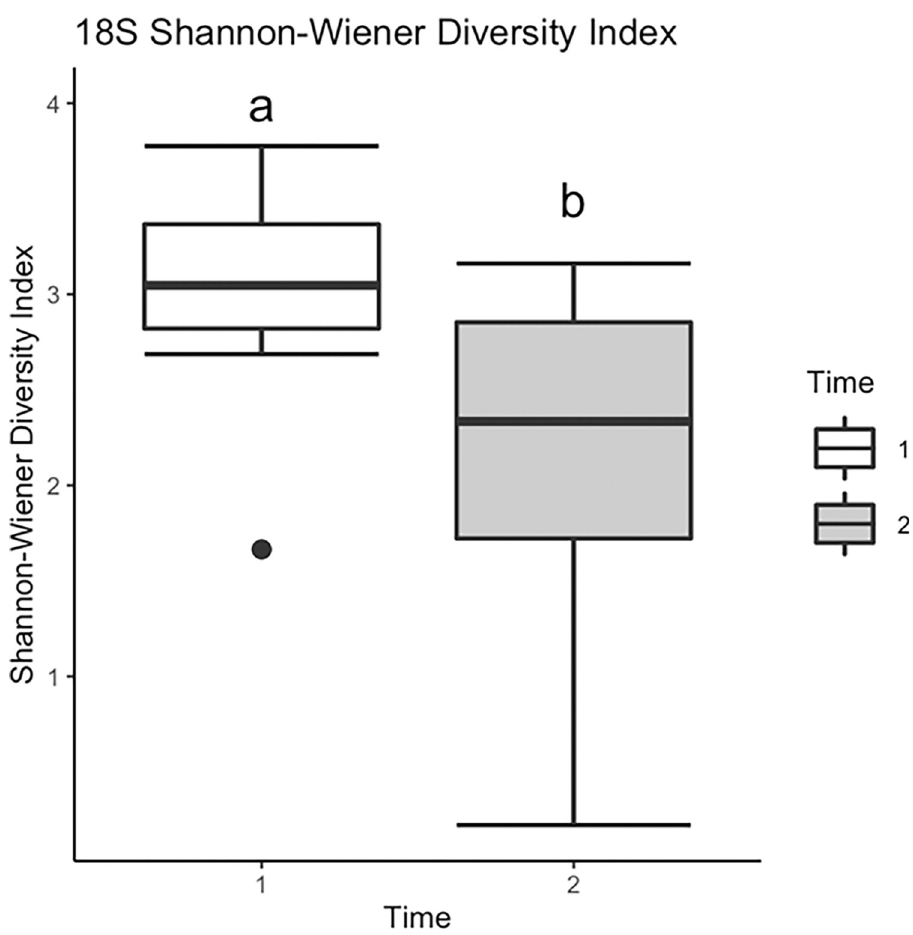
Fig 5. Lower eukaryotic (18S) Shannon diversity estimates (mean ± SE) contrasting egg surface communities across aquatic insect treatments sampled during times 1 and 2 (1 da and 4 da post fertilization, respectively).